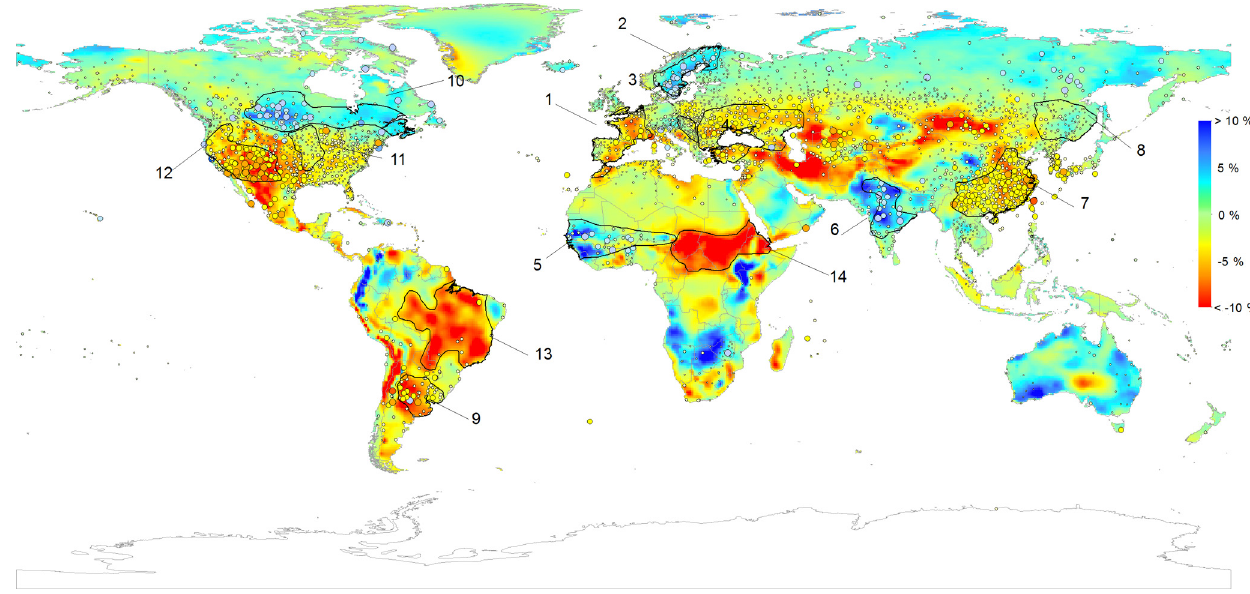
Figure 4. Spatial distribution of the selected 14 world regions, based on the high consistency in RH trends between the HadISDH and the ERA-Interim datasets. These regions were selected for the identification of the oceanic and land humidity sources by means of the FLEXPART